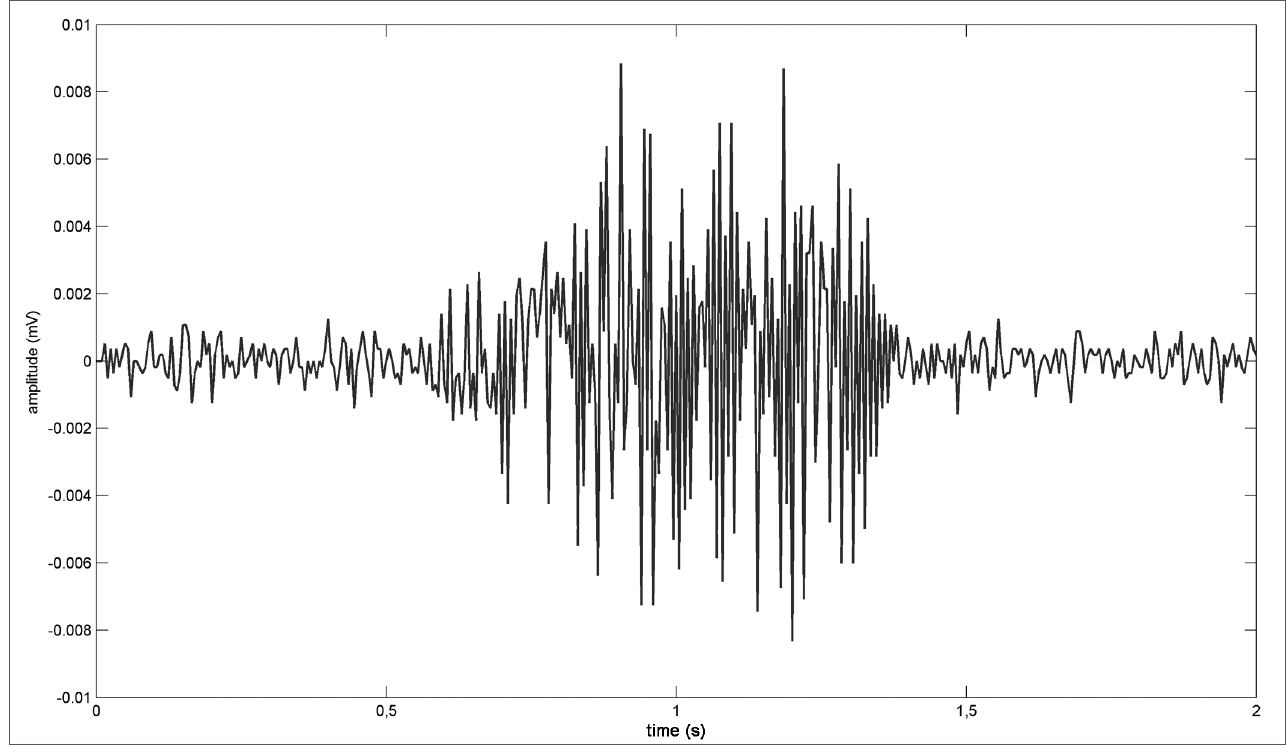
Figure 1. Snoring signal - Example of a snoring electric